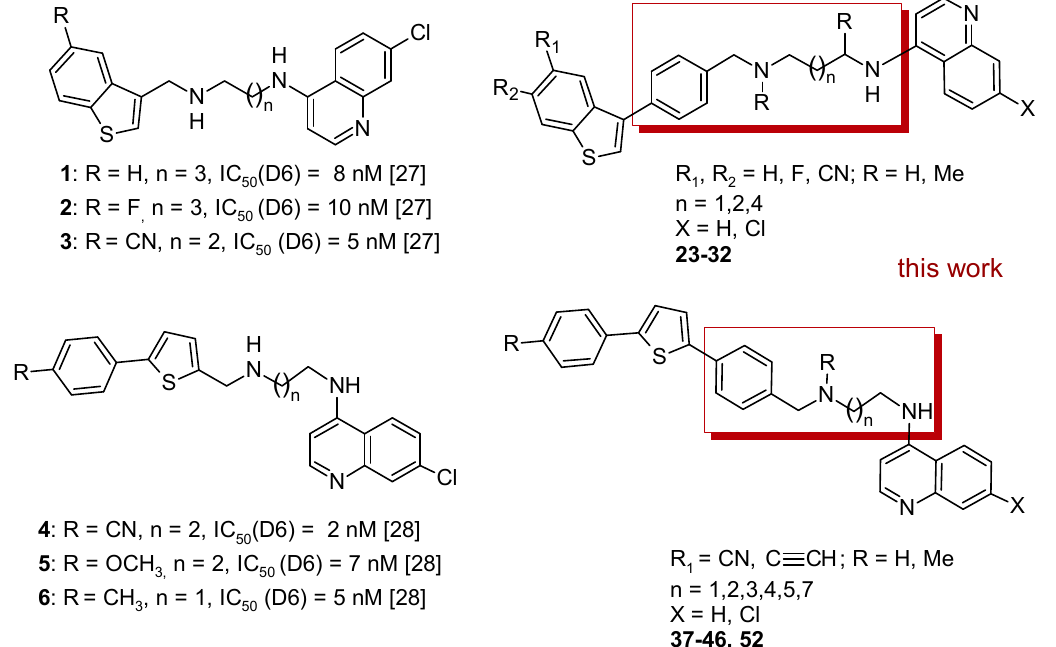
Figure 1. Benzothiophene and thiophene based antimalarials 23 – 32 , 37 – 46 and 52 .